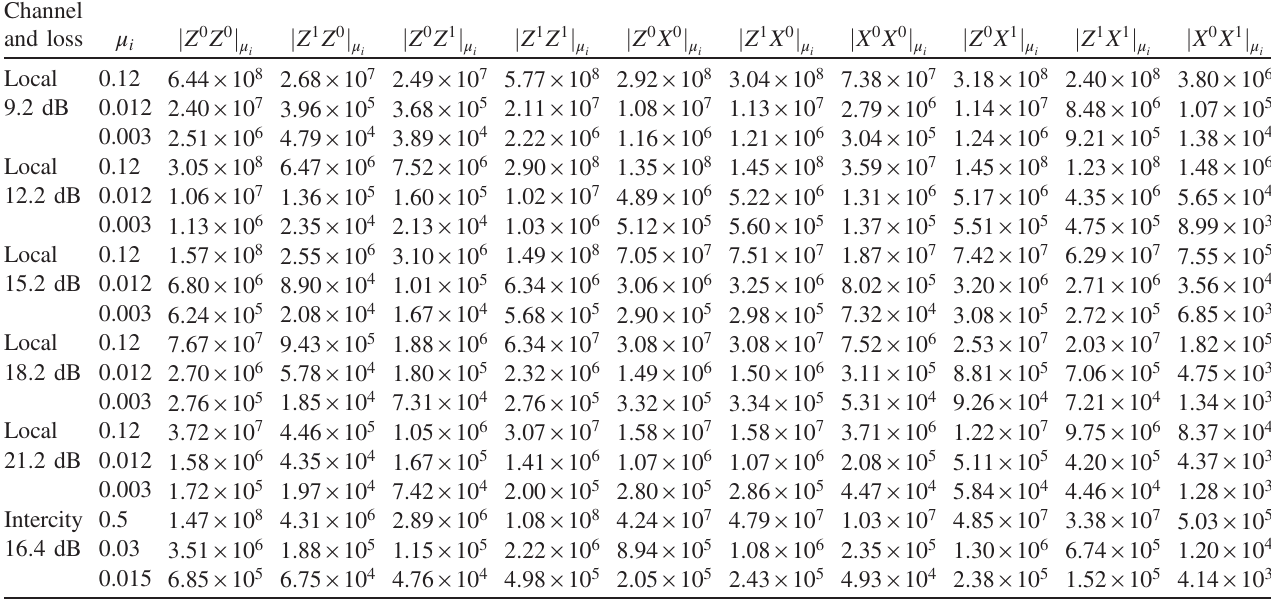
TABLE II. Experimental raw counts observed during the local tests and the 43-km intercity test. The heading j a x b y j μ recorded number of events where Alice prepares bit x with basis choice a ∈ f Z;X g and Bob detects bit y with basis choice b ∈ f Z;X g .